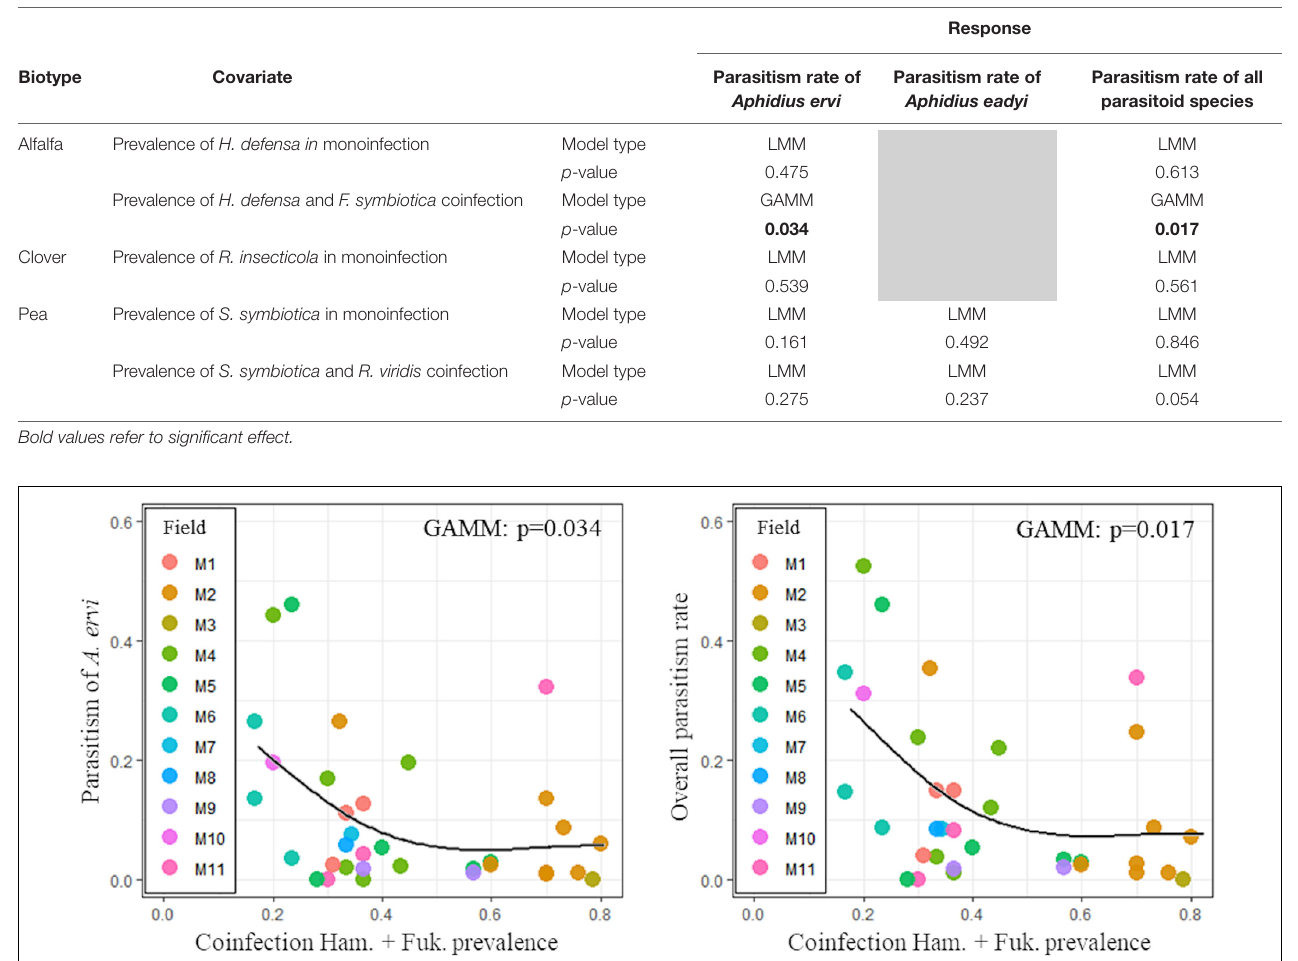
TABLE 1 | Results of statistical models (LMM: General Linear Mixed Models; GAMM: Generalized Additive Mixed Models) testing the effect of the most prevalent symbiotic associations on parasitism rate (for the dominant parasitoid species and all parasitoids).